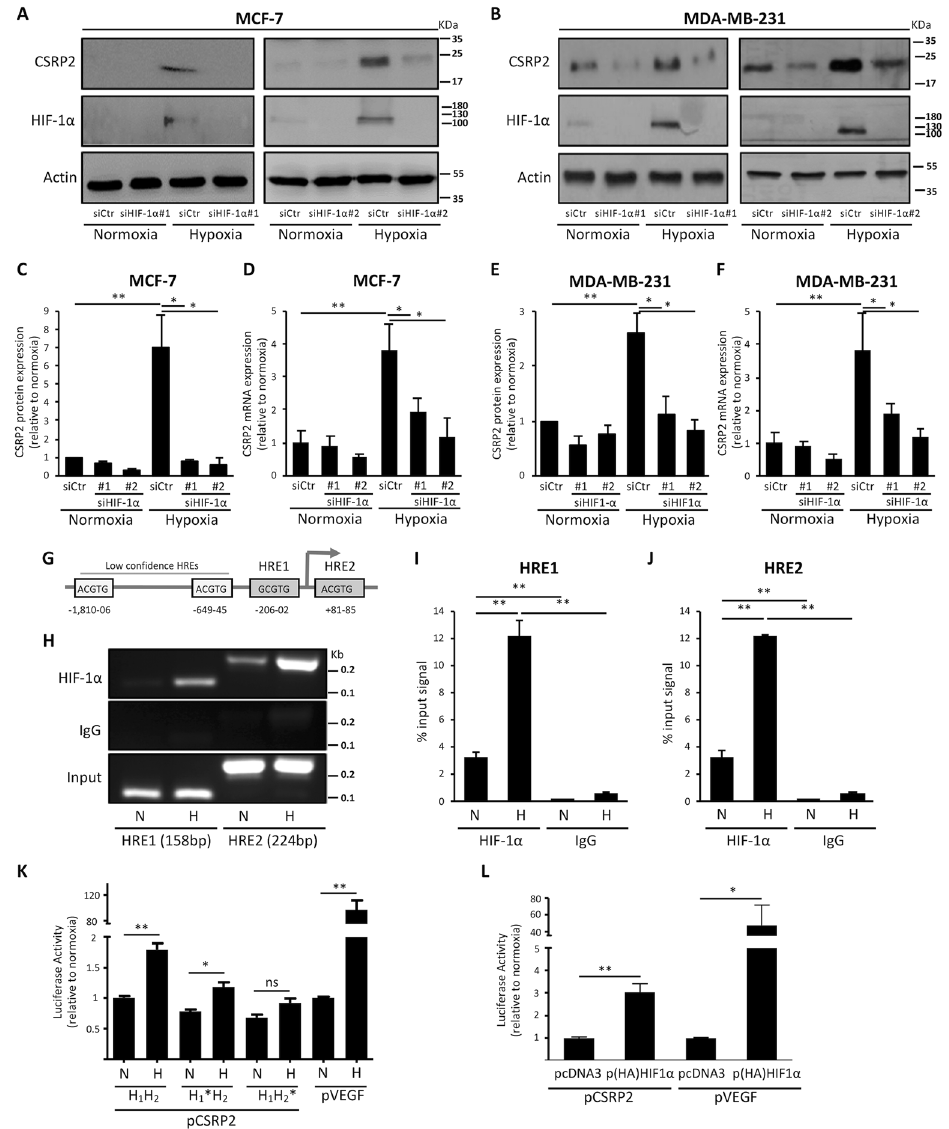
Figure 2. HIF-1 α regulates CSRP2 promoter activity. ( A , B ) Western blot analysis of CSRP2 and HIF-1 α protein levels in MCF-7 ( A ) and MDA-MB-231 ( B ) breast cancer cells incubated in normoxia or hypoxia and transfected with control siRNAs (siCtr) or two different HIF-1 α targeting siRNAs (siHIF-1 α #1 and #2). ( C , E ) After quantification, protein levels were normalized to β -actin levels and CSRP2 and HIF-1 α protein levels were expressed relative to siCtr-transfected normoxic control (set to 1). Shown are the mean ± s.e. calculated from four ( C ) and five ( E ) independent experiments. ( D , F ) qRT-PCR analysis of CSRP2 transcript levels in the same cell lines and culture conditions. Results are expressed as CSRP2 transcript levels in hypoxia relative to siCtr-transfected normoxic control (set to 1). Shown are the mean ± s.e. calculated from three ( D ) and four ( F ) independent experiments. ( G ) A schematic representation of the putative HREs identified in the proximal promoter of CSRP2. The position (relative to the transcriptional start site; TSS) of low and high confidence HREs is indicated. ( H ) ChiP analysis for HIF-1 α recruitment to CSRP2 promoter regions containing HRE1 and HRE2 in MCF-7 cells cultured in normoxic (N) or hypoxic (H) conditions. ( I , J ) Quantification of ChiP data for HRE1 (G) and HRE2 (H) from three independent experiments. Data are expressed as percentage of PCR product signal obtained for chromatin fragments immunoprecipitated with HIF-1 α antibodies or IgG (non- specific binding control) relative to the corresponding input signal. ( K ) Luciferase reporter assays to evaluate the normoxic and hypoxic activity of a wild type CSRP2 promoter with intact HRE1 and HRE2 (H1H2) and two variants with point mutations in HRE1 (H1 * H2) or HRE2 (H1H2 * ) in MCF-7 cells. VEGF promoter was used as a positive control. Data are expressed as mean of luciferase signal ± s.e. in hypoxia relative to normoxic control (set to 1; n = 3 independent experiments). ( L ) Luciferase assays for the wild type CSRP2 promoter in MCF-7 cells transfected with a control empty plasmid (pcDNA3) or HIF-1 α expressing plasmid (p(HA) HIF-1 α ). Data are expressed as mean of luciferase signal ± s.e. in hypoxia relative to normoxic control (set to 1; independent experiments). * p < 0.05; ** p <